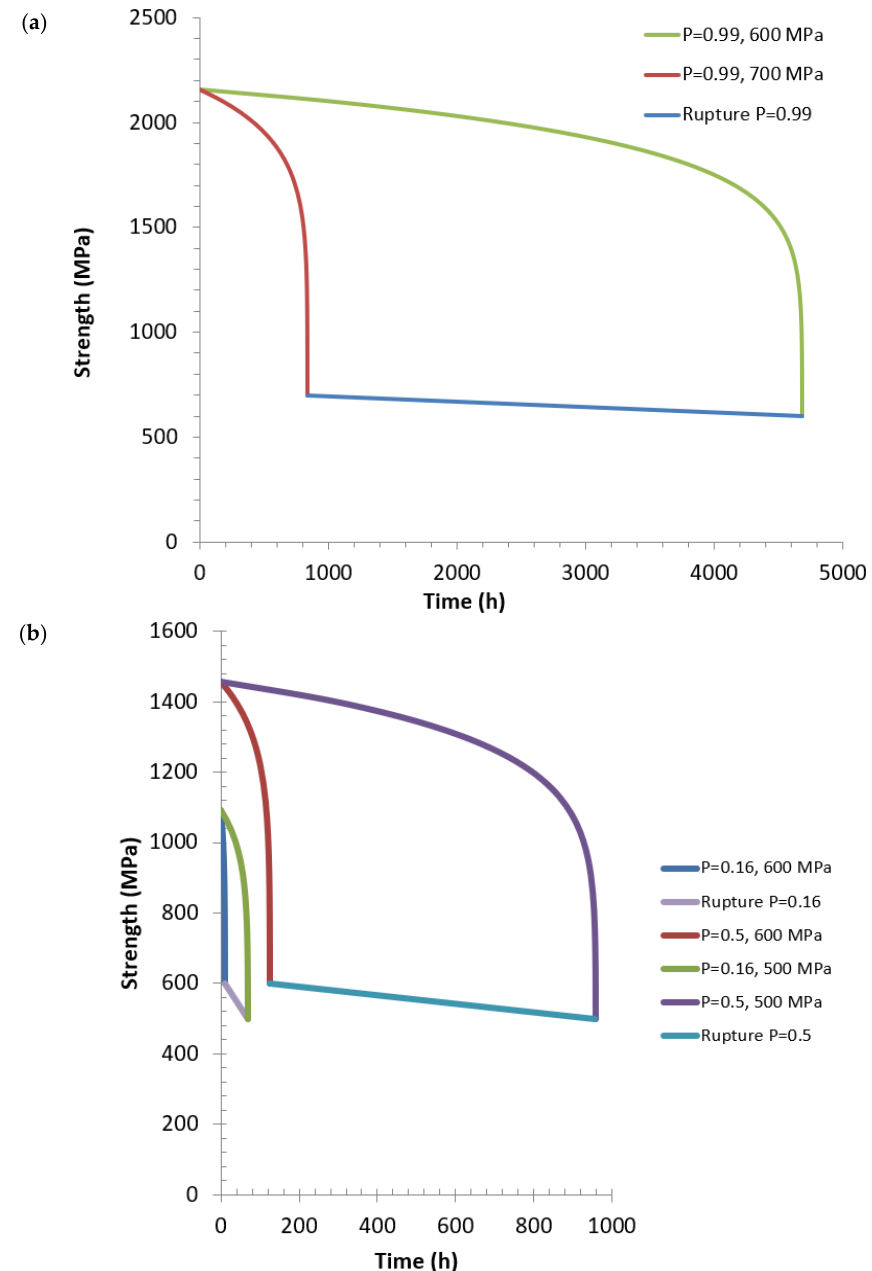
Figure 6. Strength degradation as a function of fatigue time for specific single filaments subjected to constant stress (500 MPa and 600 MPa): ( a ) The critical filament for a tow under constant force ( P = α t = 0.16), average filament ( P = 0.5); and ( b ) the strongest filament ( P = 0.99).